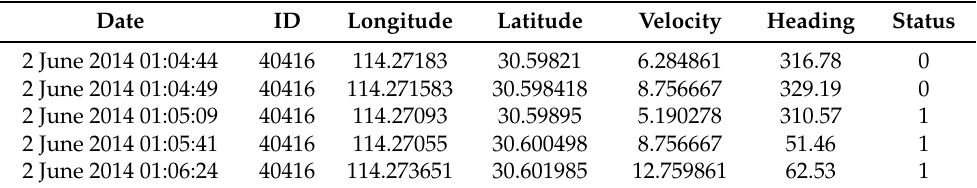
Table 1. The taxi trajectory data.